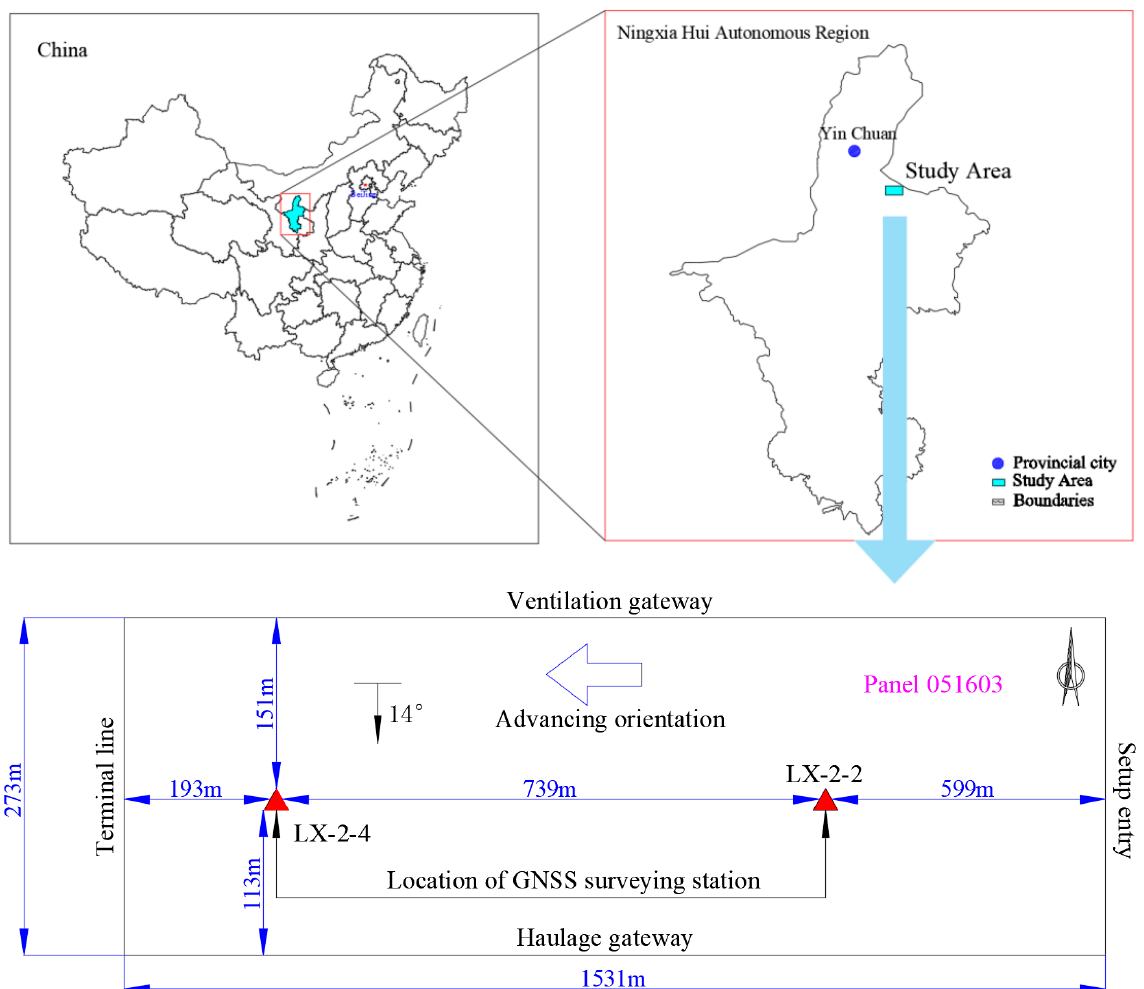
Figure 5. Schematic diagram of the Lingxin colliery location and automatic surveying stations above 051603 coalface.